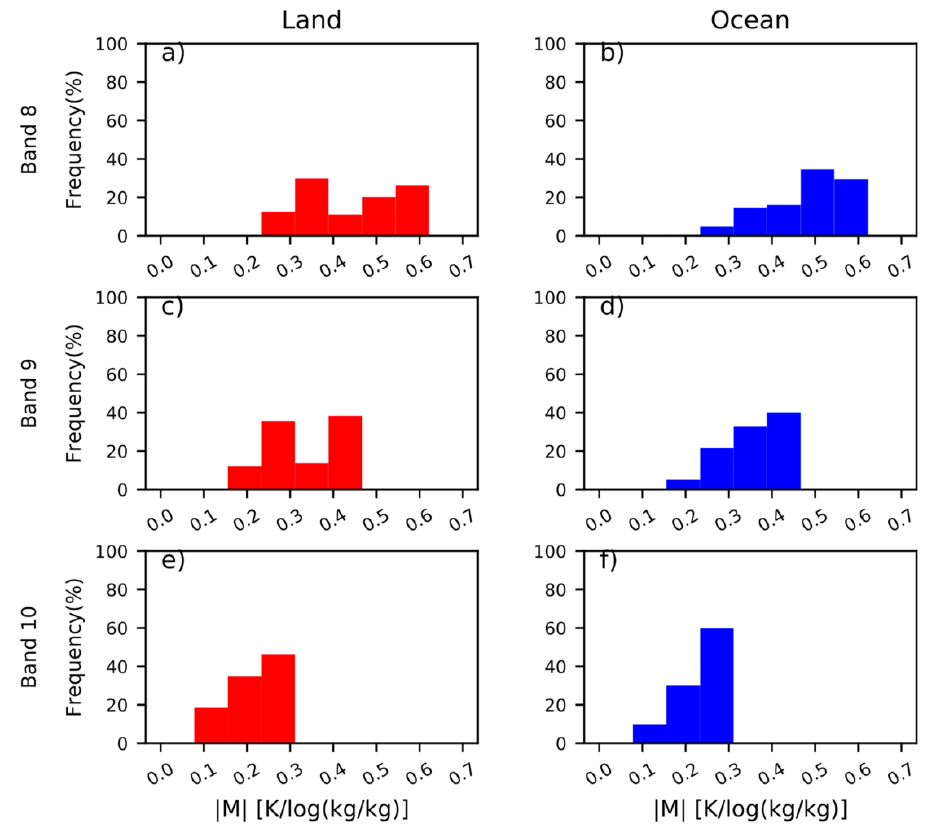
Figure 9. The frequency of distribution of | M | over land and ocean for ( a, b ) Band 8, ( c, d ) Band 9 and ( e, f ) Band 10, respectively.